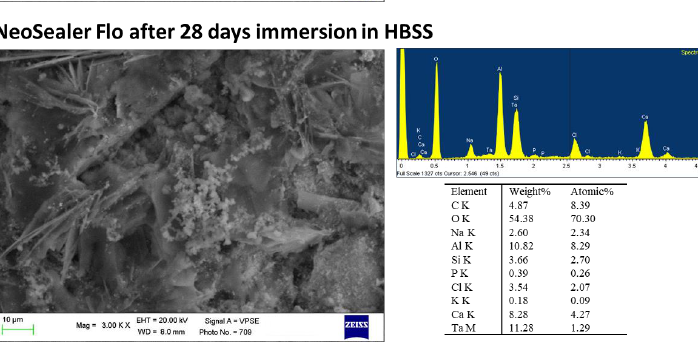
Figure 4. ESEM images at 3000× of NeoSealer Flo before and after immersion in HBSS. The set sam- ple was characterized by a homogeneous surface with granules of different sizes and shapes. EDX analyses revealed the constitutional elements of the sealer, namely Ta, Ca, Si and Al. After 28 days immersion in HBSS, ESEM images revealed a less uniform surface with an irregular layer, charac- terized by needle-like structures and granules that were agglomerated in larger irregular structures. EDX microanalysis revealed an increase in Ca and Al, stability of Si and Ta and the appearance of P.